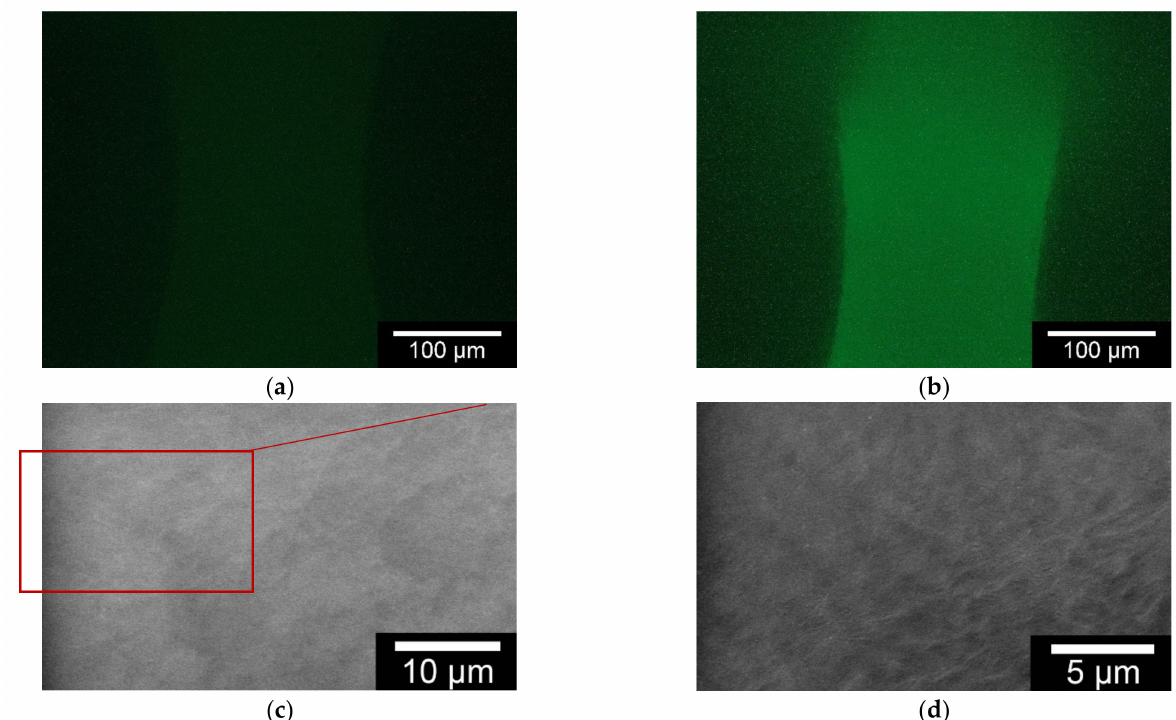
Figure 4. Fluorescense Images of ( a ): uncoated PCL scaffolds; ( b ): collagen-I coated PCL scaffolds; immunoassay with Alexa Fluor 488 (excitation at 495 nm (blue), emission 519 nm (green); Images taken with Olympus BX 53 Fluorescense Microscope, 10x magnification; ( c ): ESEM image of collagen-I coated scaffold Magnification 6400x (HFW 46.6 µ m); ( d ):enlargement of a specific area of the ESEM image (red square in Figure 4c) of the collagen-I coating 12800x (HFW 23.3 µ m), ESEM images taken with FEI Quanta 250 FEG with Large Field Detector, 10 kV acceleration voltage; 130